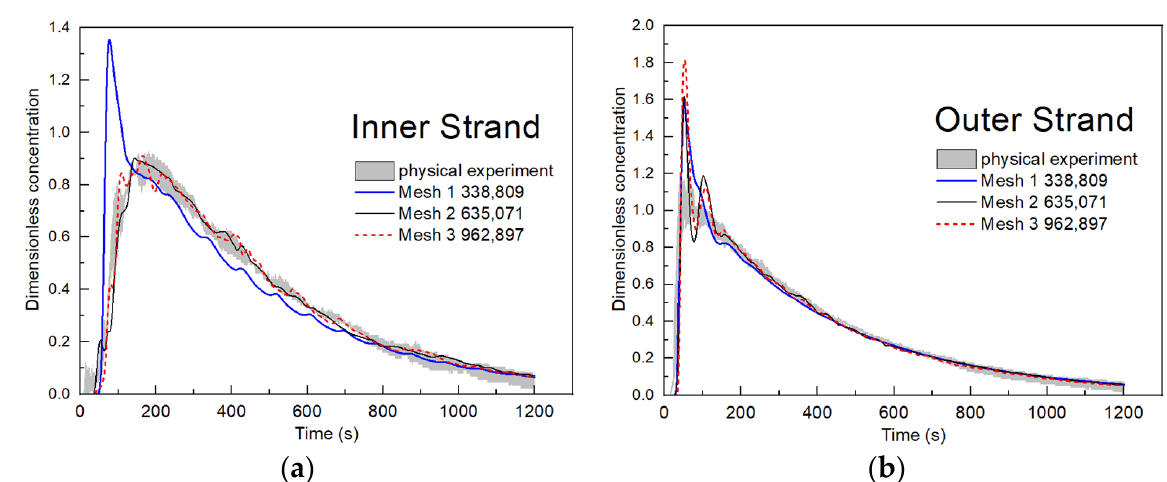
Figure 4. Verification of RTD curves and experiments of inner and outer strands under different mesh: ( a ) inner strand, ( b ) outer strand.